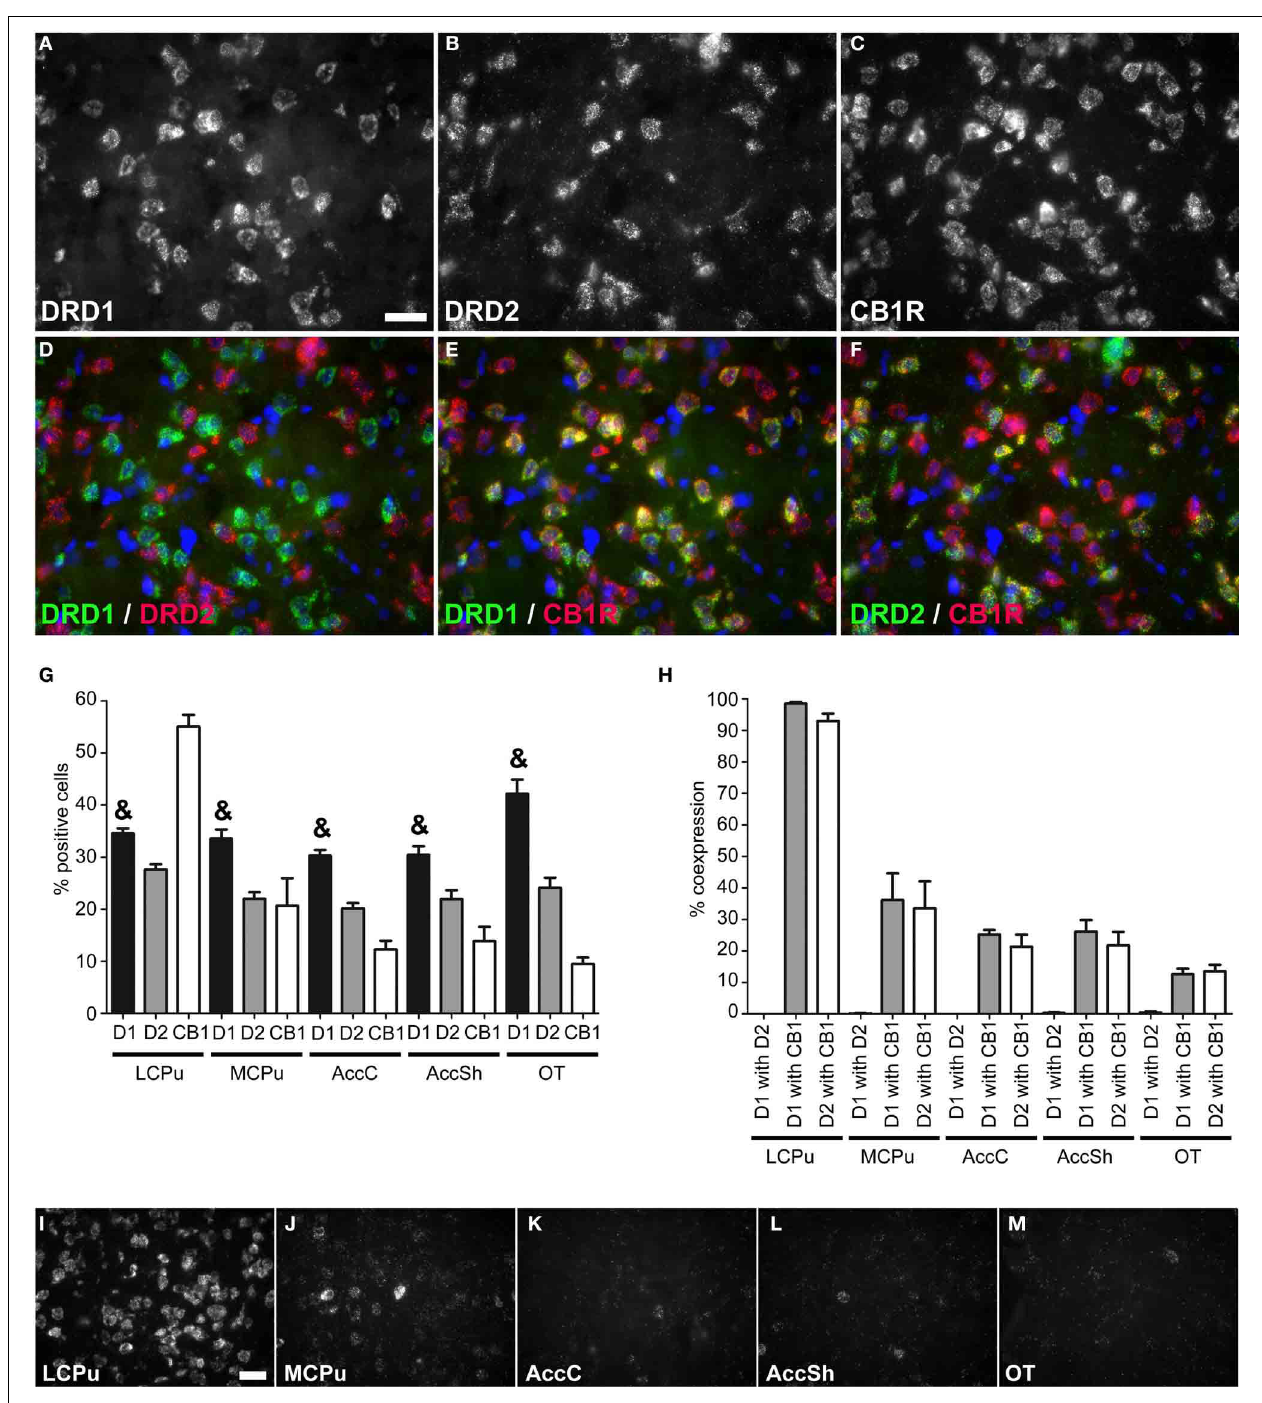
FIGURE 2 | Coexpression of the cannabinoid receptor 1 with both DRD1 and DRD2 . (A–F) Example of staining in the lCPu. Nuclei were stained using DAPI (blue). Clear expression for the DRD1 (A) , DRD2 (B) and cannabiniod 1 receptor ( CB1R ) (C) . White bar, 25 μ m. (D) No coexpression found for DRD1 and DRD2 . (E,F) Clear coexpression for DRD1 and CB1R and DRD2 and CB1R . (G) Quantification of the expression of DRD1 , DRD2 and CB1R. Bars represent the mean percentage ( + s.e.m.) of DAPI stained nuclei that are positive for DRD1, DRD2, or CB1R , where “&” indicates a significant